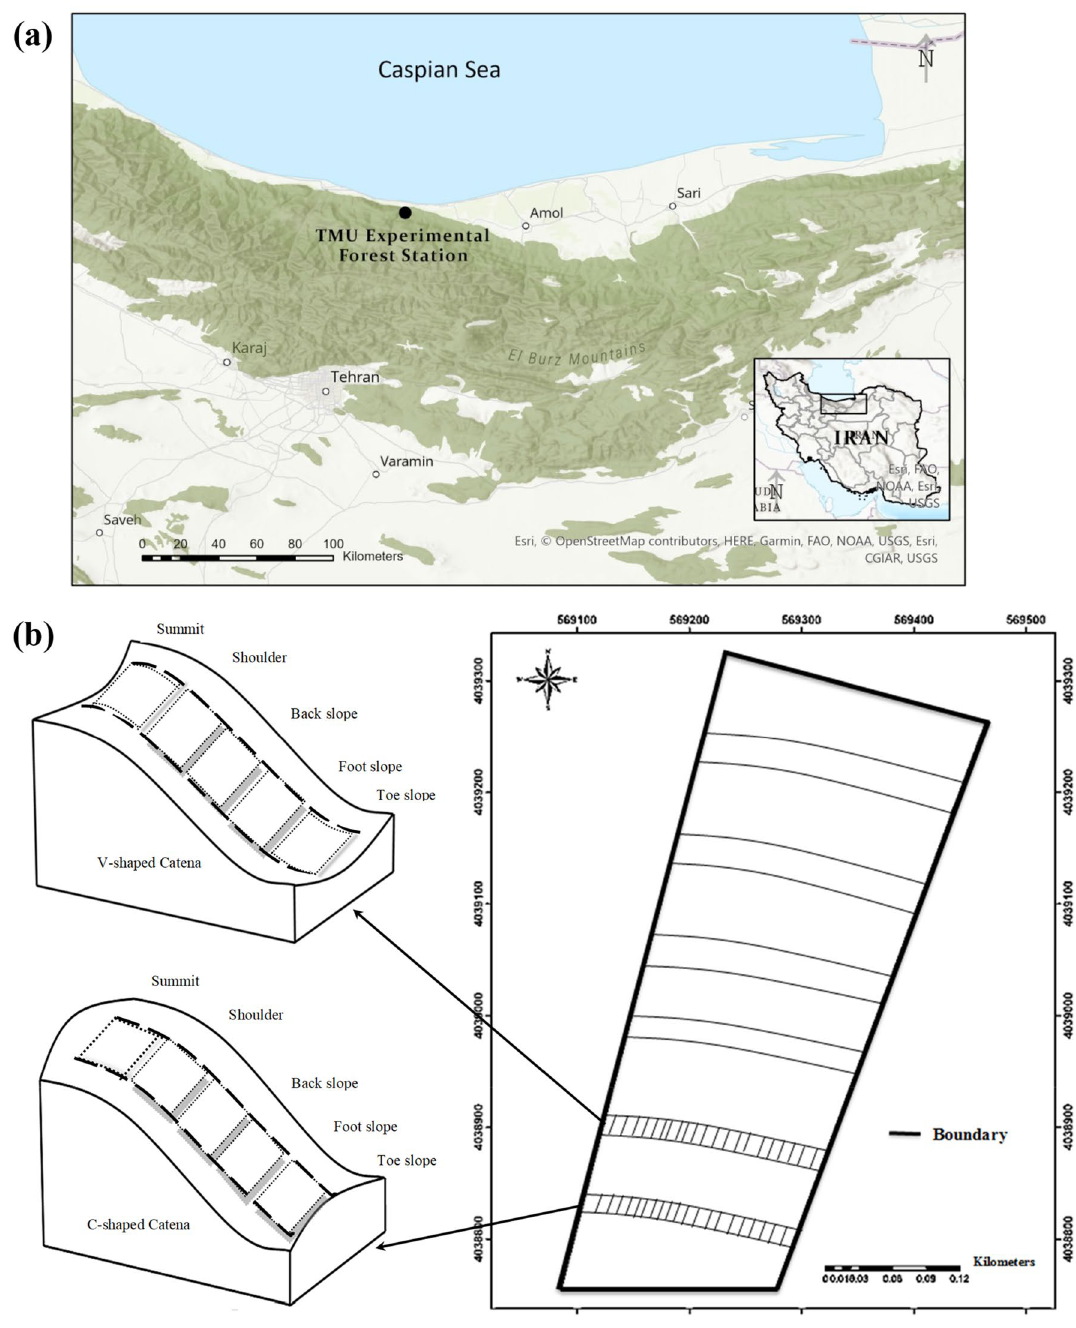
Figure 1. Location of the study area ( a ), and a diagram illustrating orientation, and the shape of the two major catena types, as well as their approximate locations in the study area ( b ). Figure ( a ) was produced using ArcGIS Pro version 2.8.6, https:// pro. arcgis. com/ en/ pro- app/2. 8/ get- start ed/ get- start ed. htm, and Figure ( b ) was drawn using Microsoft Word 2013 V 15.0.5085.1000, https:// www. micro soft. com/ en- ie/ micro soft- 365/ previ ous- versi ons/ micro soft- word- 2013, and was first published in Fazlollahi Mohammadi et al.